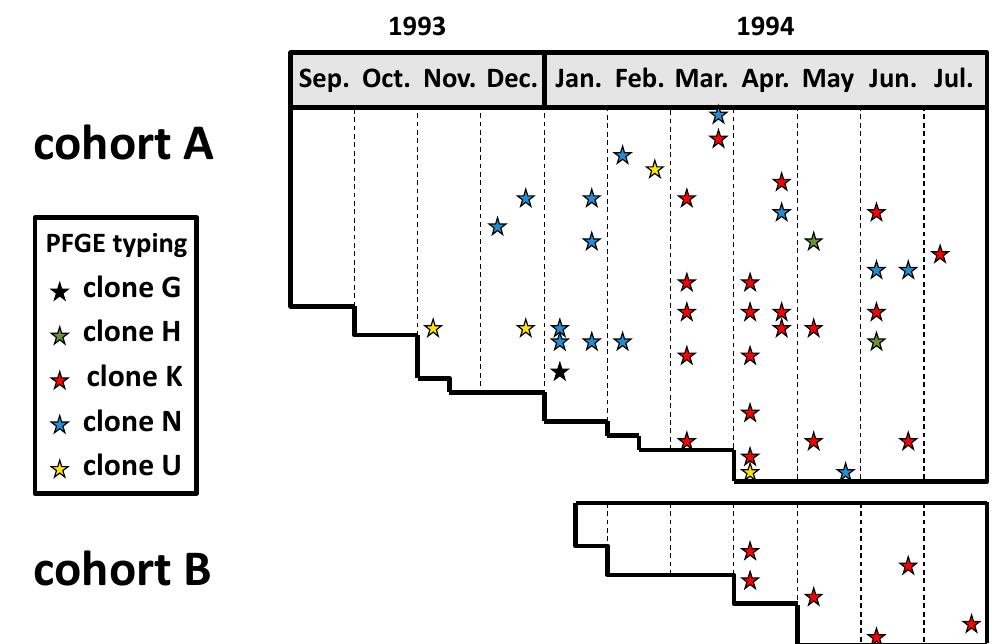
Figure 1. Dissemination of K. kingae clones among two cohorts of attendees at an Israeli daycare center. Horizontal lanes: individual attendees. Each star represents a positive pharyngeal culture, while the different colors represent distinct PFGE clones.